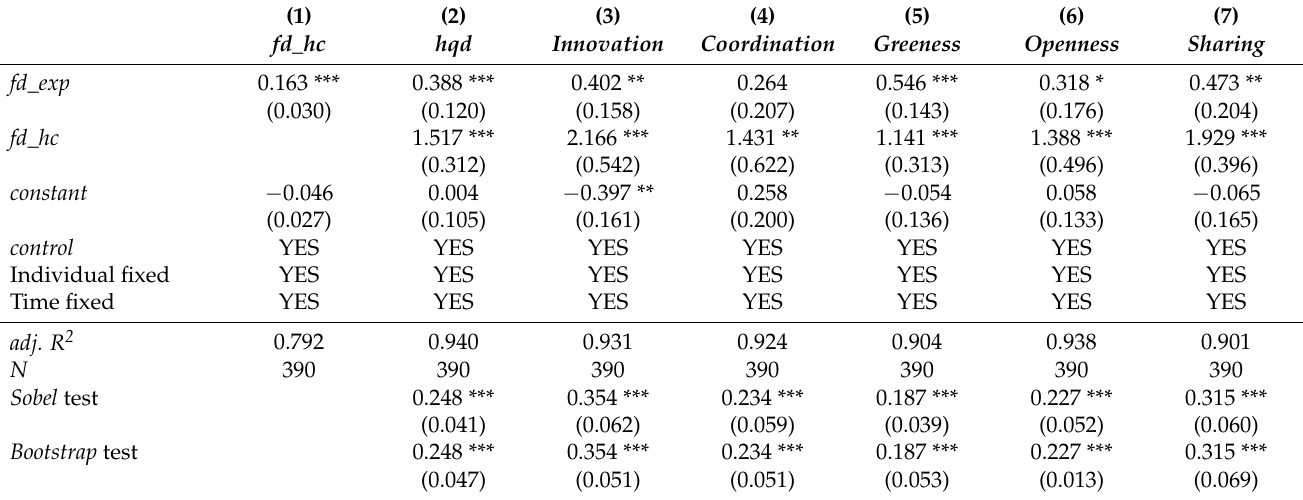
Table 8. Mediating effects of healthcare expenditure preferences based on segmentation dimensions.